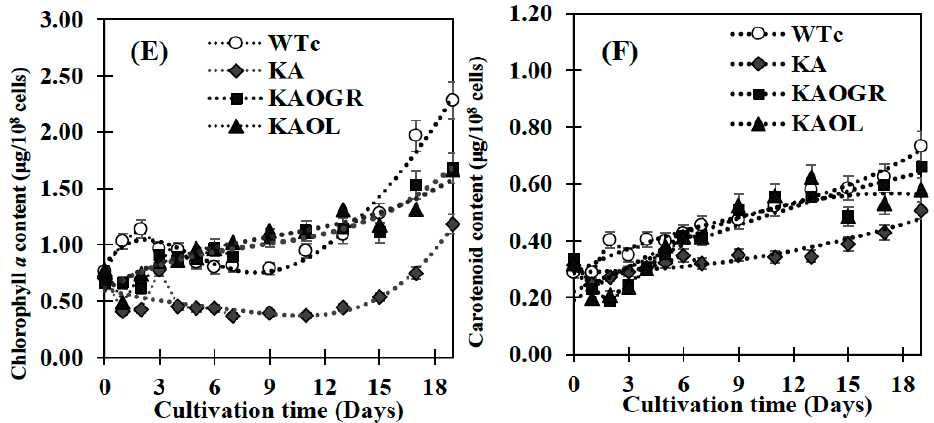
Figure 4. Growth curve ( A ), growth rate and doubling time ( B ), digital images of cell cultures ( C , D ), chlorophyll a content ( E ) and carotenoid content ( F ) of the Synechocystis PCC6803 wild-type control (WTc) and engineered KA strains. Cells were grown in BG 11 medium for 19 days. Error bars represent standard deviations of means (mean ± S.D., n = 3). For ( C , D ), images of 10-day cell culture flasks of WTc and KA were depicted. Floating white droplets in KA-cultured flask represent free fatty acids (FFAs) secreted to the medium (white arrow).